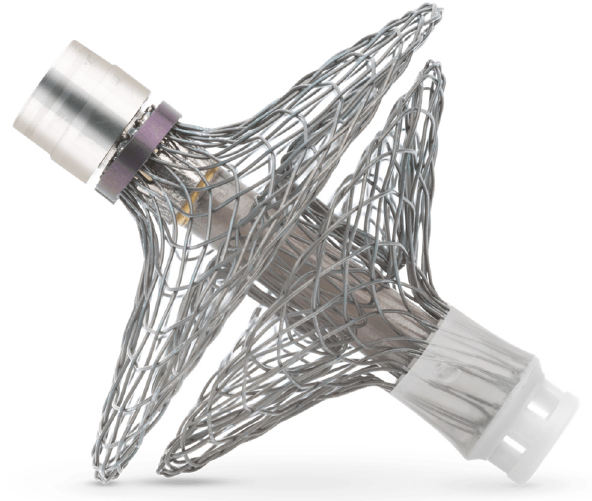
Figure 11. The V-LAP TM Left Atrial Pressure Sensor. Used with permission from Vectorious Medical Technologies, Tel Aviv, Israel.